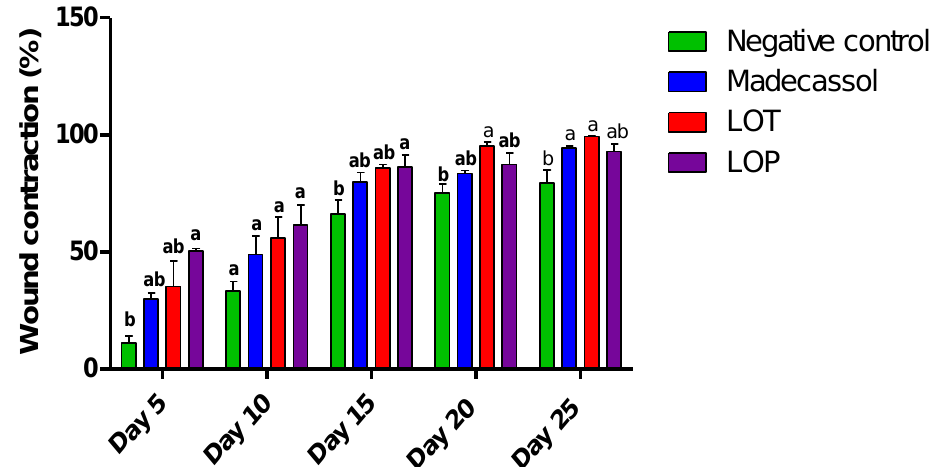
Figure 6. Wound-healing effect of the hydro-ethanolic (LOT) and polyphenolic (LOP) extracts of L. officinalis and the control groups. letters indicate significant differences ( p < 0.05) using a one-way ANOVA analysis (Tukey’s test). The data represent the mean ± SD.